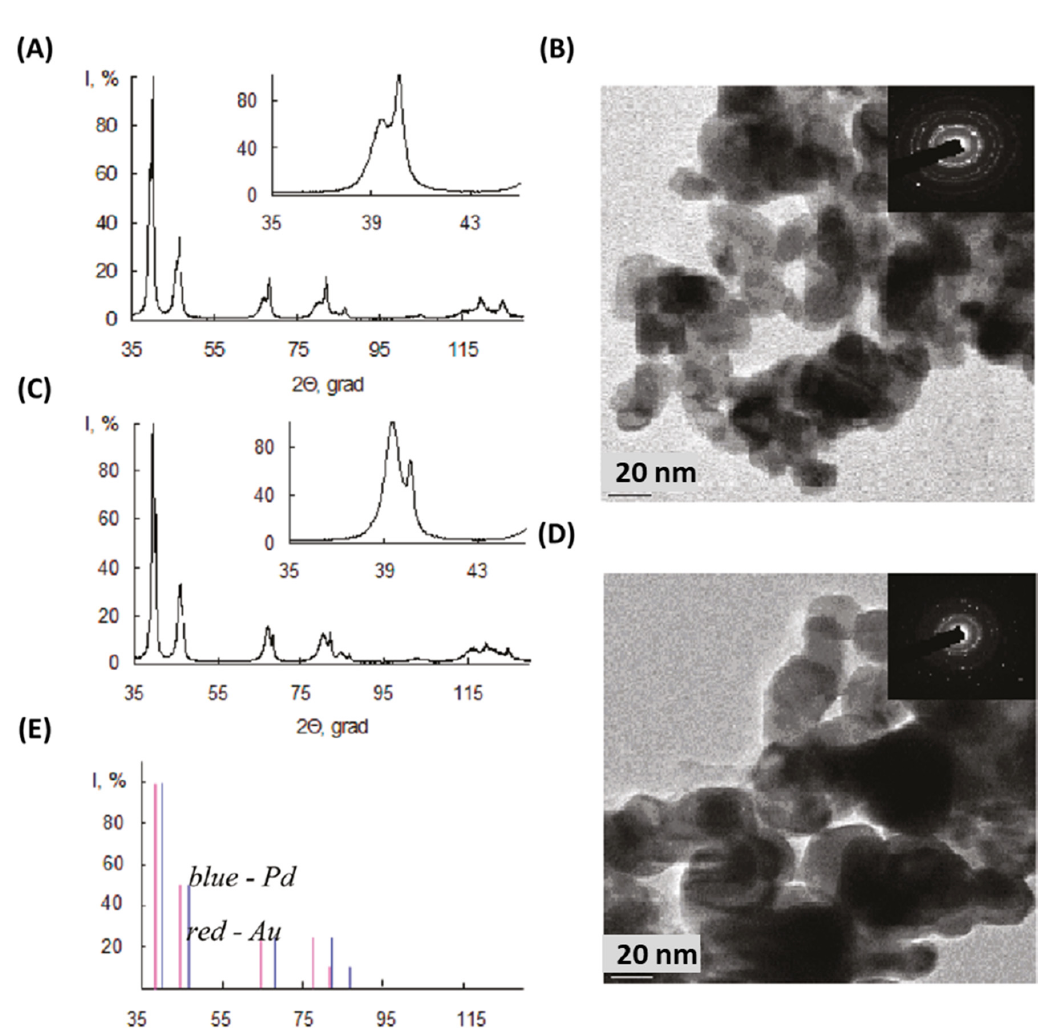
Figure 12. PXRD data for Pd/Au NPs synthesized in 15 min ( A ), and 60 min ( B ) under µwH; ( C , D ) PXRD and TEM respectively for Pd/Au NPs synthesized in 60 min, scale bars are 20 nm; ( E ) shows reference XRD patterns. Adapted with permission from the American Chemical Society. Copyright 2011 American Chemical Society.